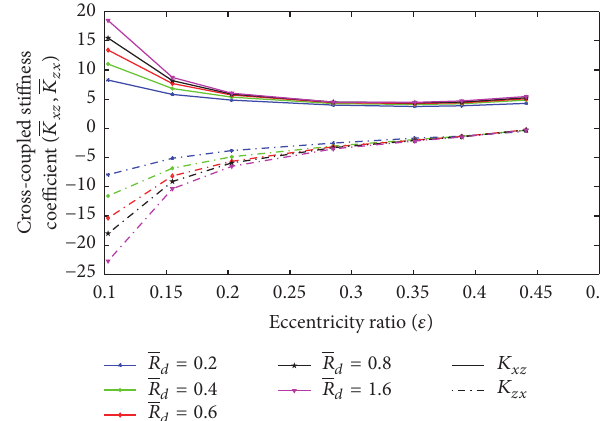
Figure 7: Effect of relief track depth ratio on friction variable.